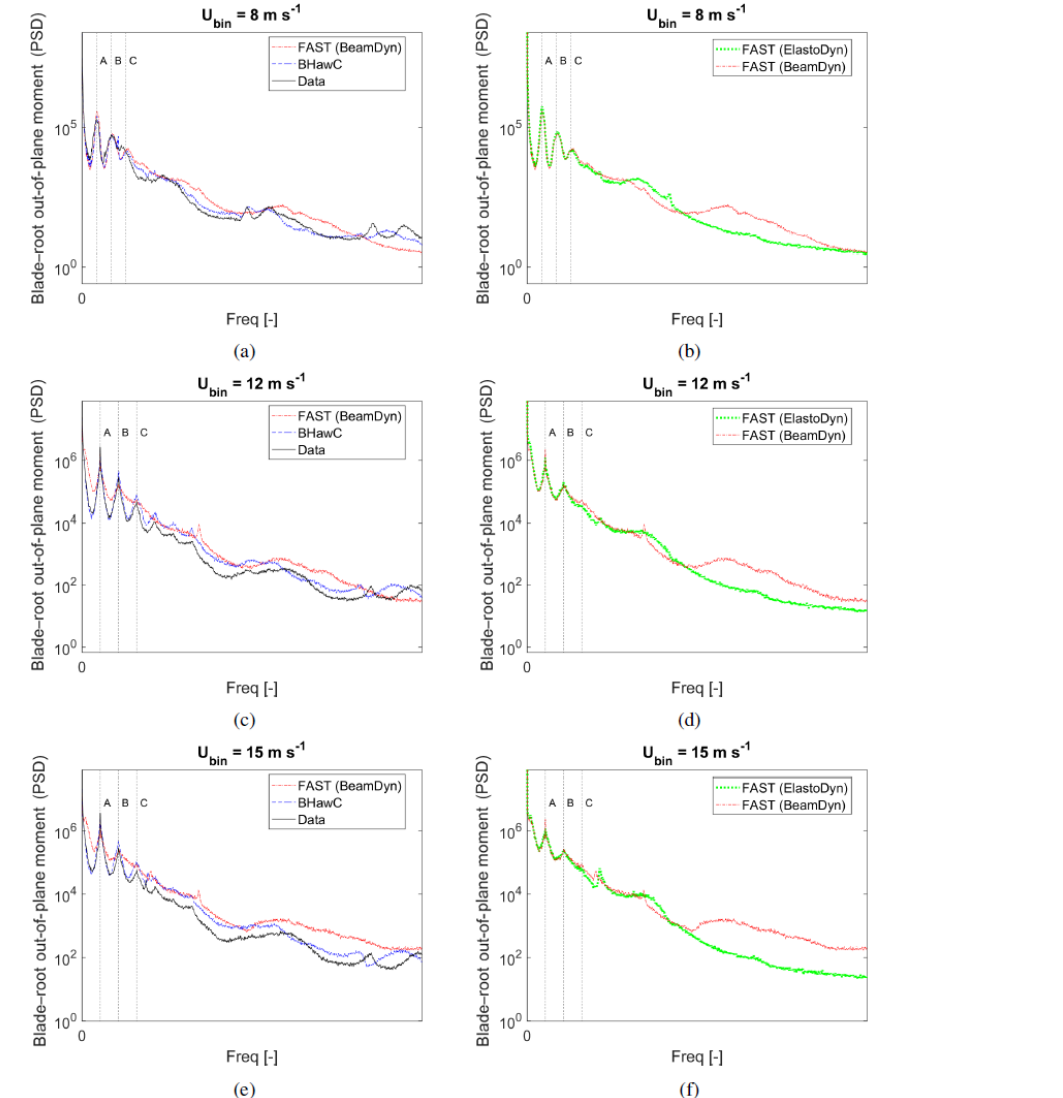
Figure 18. PSDs of the blade-root out-of-rotor-plane bending moments. The three sets of graphs represent the ensemble-averaged PSDs from the inflow velocity bins at 8ms − 1 (top), 12ms − 1 (center), and 15ms − 1